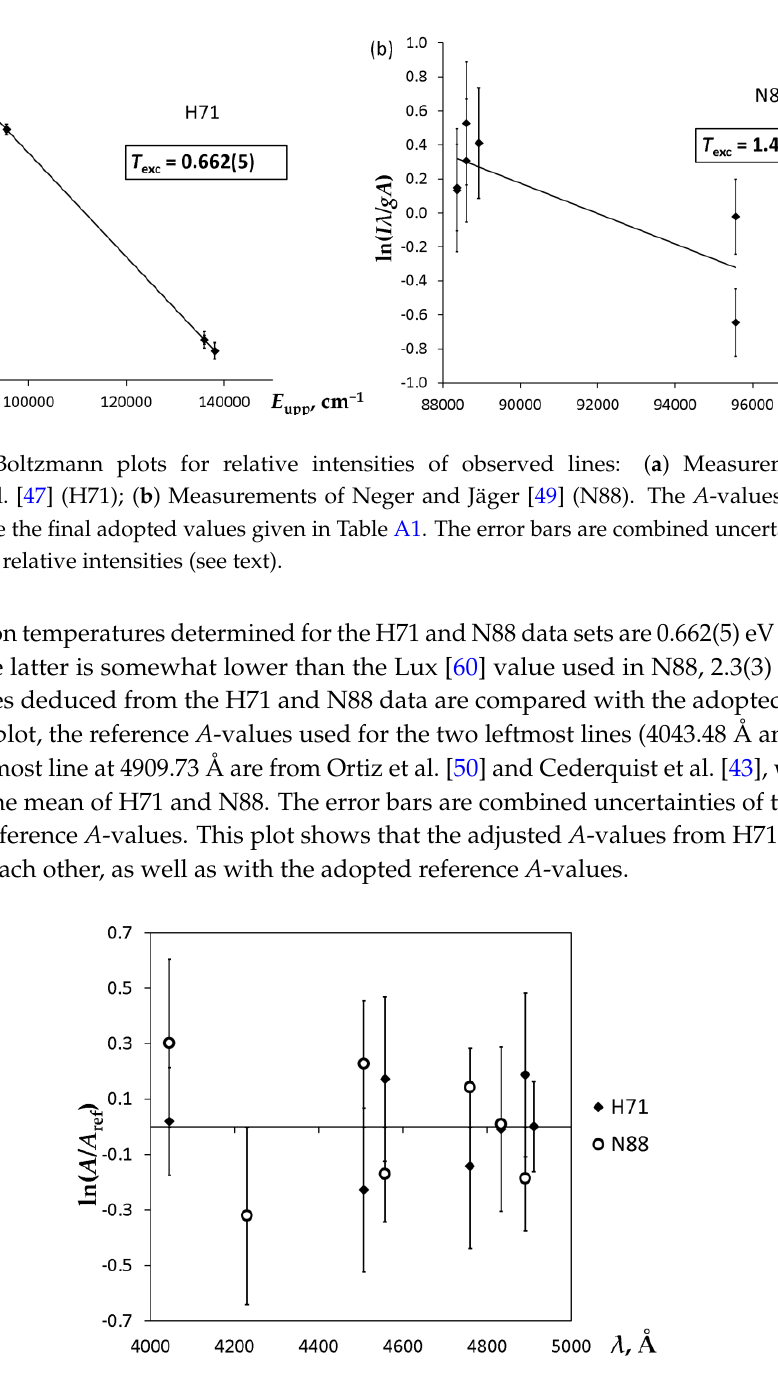
Figure 5. Comparison of adjusted A -values deduced from the line ratios reported by Hefferlin et al. [47] (H71) and by Neger and Jäger [49] (N88). The error bars are combined uncertainties of the measured line ratios and adopted reference A -values.